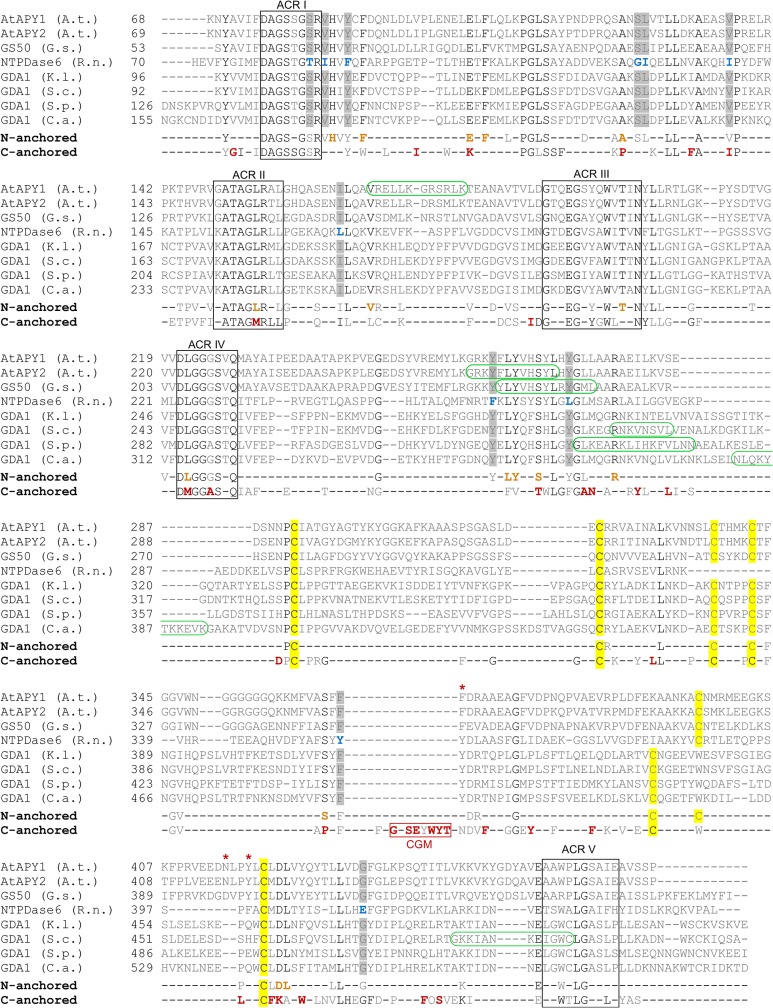
Alignment of single-pass type II membrane Golgi E-NTPDases.The sequence alignment was generated using all known Golgi E-NTPDase sequences which contain one TM near the N-terminus (= N-anchored): AtAPY1 from A. thaliana (A. t.) [UniProtKB: Q9SQG2], AtAPY2 from A. t. [UniProtKB: Q9SPM5], GS50 from Glycine soja (G. s) [UniProtKB: Q9FVC3], NTPDase6 from Rattus norvegicus (R. n.) [UniProtKB: Q9ER3], GDA1 from Kluyveromyces lactis (K. l.) [UniProtKB: Q9HEM6], GDA1 from Saccharomyces cerevisiae (S. c.) [UniProtKB: P32621], GDA1 from Schizosaccharomyces pombe (S. p.) [UniProtKB: Q9UT35] and GDA1 from Candida albicans (C. a.) [UniProtKB: Q8TGH6]. The sequences (without the N-terminal regions) are presented in descending order of identity to AtAPY1: AtAPY1 and AtAPY2 share the highest (87% identity) and AtAPY1 and C. a. GDA1 the lowest identity (24%). Their consensus is presented as “N-anchored”. The ACRs are boxed. Highly conserved cysteines are highlighted in yellow. The candidate amino acids for substrate binding in AtAPY1 (see Fig. 12) are labeled with red asterisks. Differences between the NTPDase6 and the other seven N-anchored Golgi E-NTPDases are shown in blue and highlighted in gray, respectively. A putative CBS is circled in green. The “C-anchored” consensus from all known Golgi E-NTPDase sequences which contain one TM near the C-terminus (= C-anchored) was generated separately: NTP-1 from C. elegans (C. e.) [UniProtKB: Q18411], S. p. YND1 [UniProtKB: Q9USP2], S. c. YND1 [UniProtKB: P40009] and K. l. YND1 [UniProtKB: Q70KY5]. For the extraction of the consensus sequences, the sequences of the regions from ACR I to ACR V were evaluated, omitting the respective N- and C-terminal parts with the TMs from the analysis. Amino acids present in all members of the N- and/or C-anchored class are in black. If the amino acids are exclusively present in all members of one class, they appear in orange or red, respectively. The 8-aa region marked CGM (C-anchored Golgi NTPDase conserved motif) is unique to C-anchored Golgi E-NTPDases.